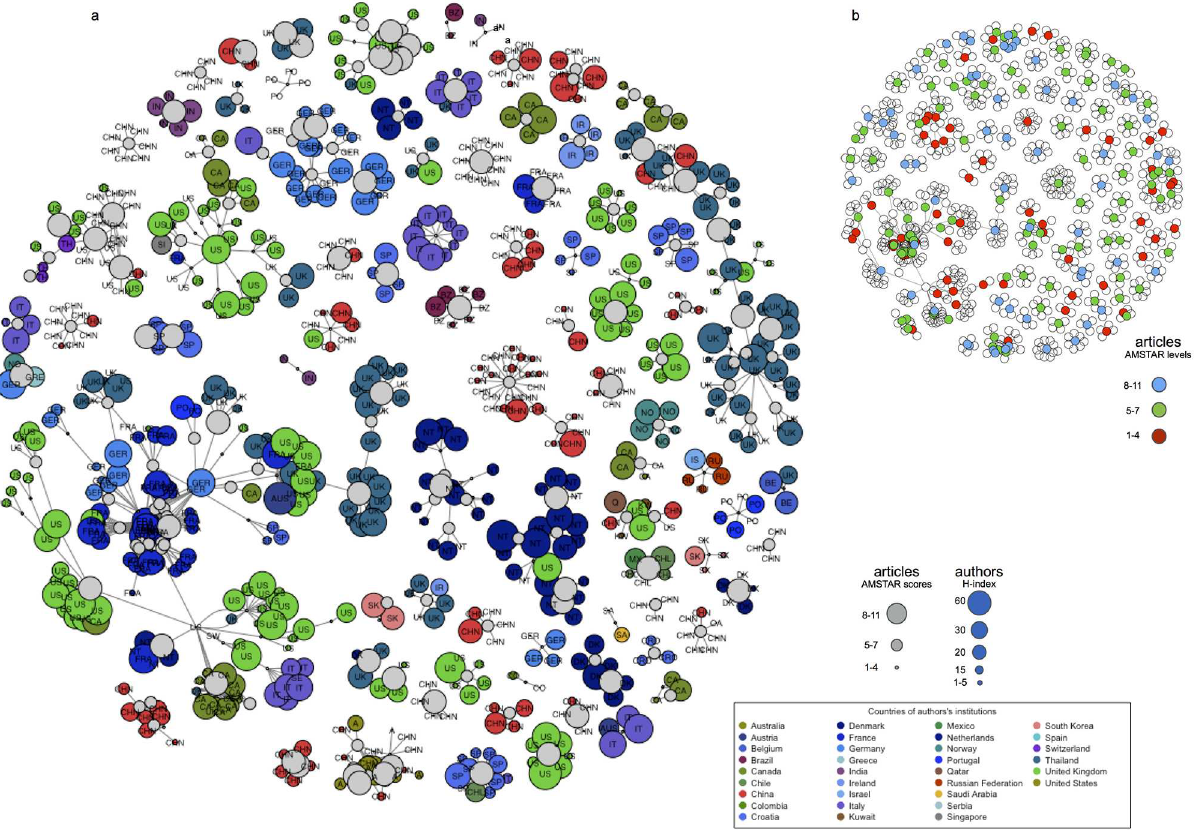
Fig 1. Whole author-paper affiliation network. (a). Nodes that representauthors are colored and labeledbasedon their institution’s country. Grey nodes represent the reviews on psoriasiswhich were finally included.Node size is proportional to the author’s H-indexor AMSTAR score respectively. Edges connect both types of nodes, thus every author and their collaborators are linked to the shared publication.(b). Same network, althoughonly nodesrepresentingarticles are colored basedon AMSTAR levels.